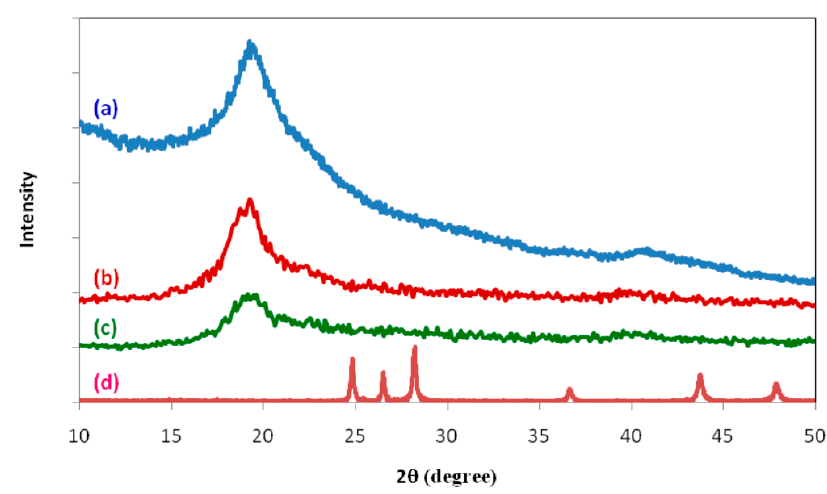
Figure 14. The XRD of: ( a ) pure PVA; ( b ) PVA incorporated 0.02 M CdS; ( c ) PVA incorporated 0.04 M CdS; ( d ) pure CdS [133].